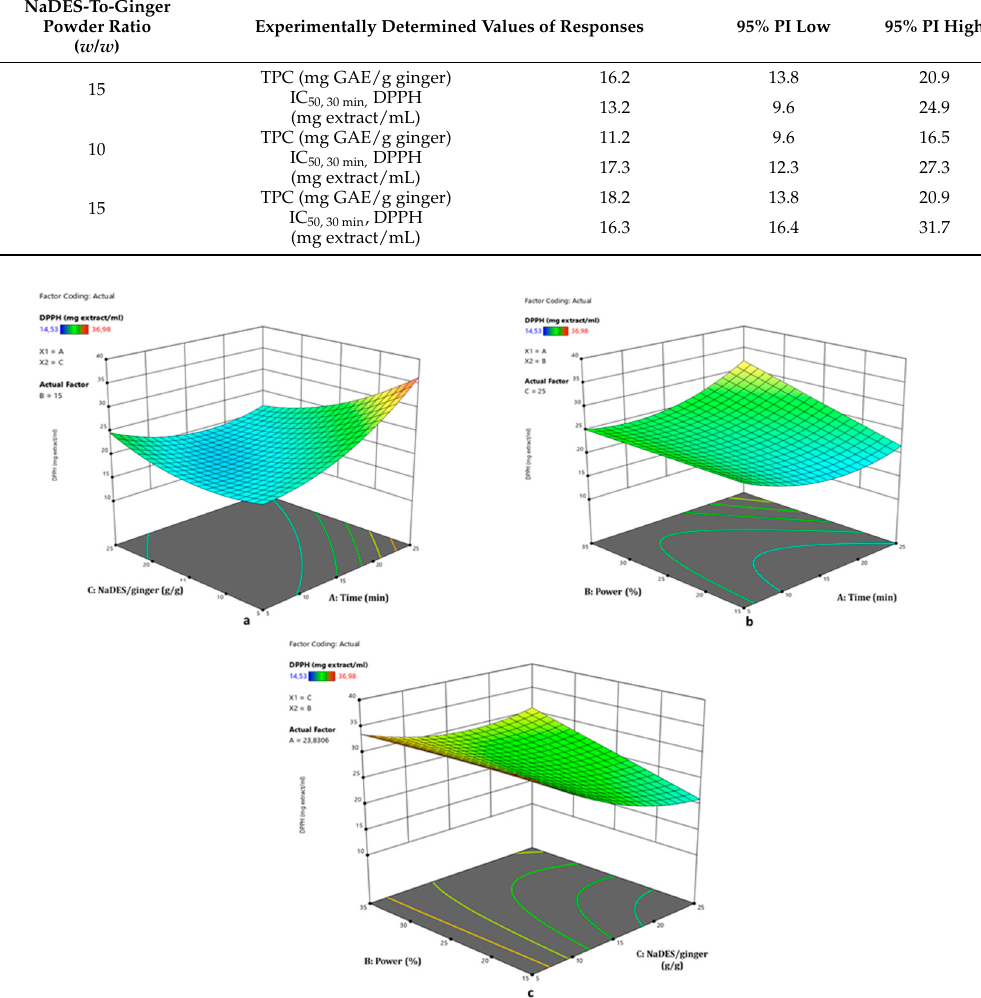
Table 5. Model confirmation data.